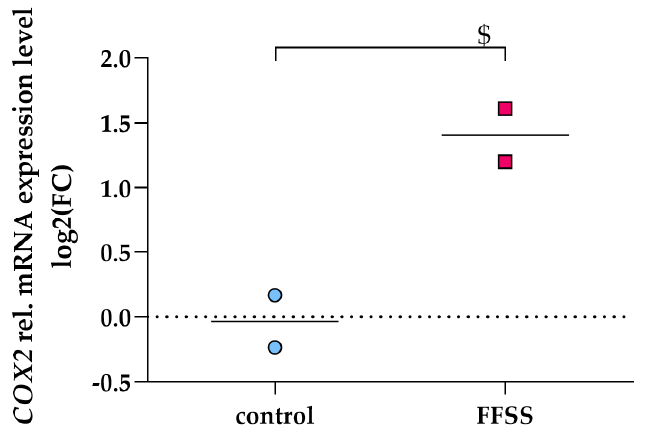
Figure 7. FFSS upregulated COX2 gene expression in hPC (pink squares). qPCR results are presented as relative mRNA expression level normalized to GAPDH and referred to control group (blue circles). COX2 upregulation was quantified after 2 h of FFSS with 2 dynes/cm 2 . Statistics: $, p < 0.05, assessed by a two-tailed Student’s t -test. Each datapoint represents the mean of an independent experiment (performed in duplicate on different cell passages and on different dates, each consisting of n = 5–6 replicates per treatment) and plotted as combined mean (horizontal lines).